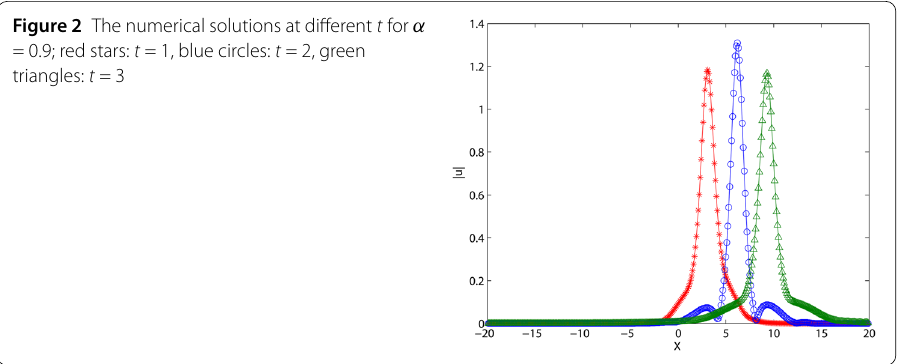
Figure 2 The numerical solutions at different t for α = 0.9; red stars: t = 1, blue circles: t = 2, green triangles: t = 3